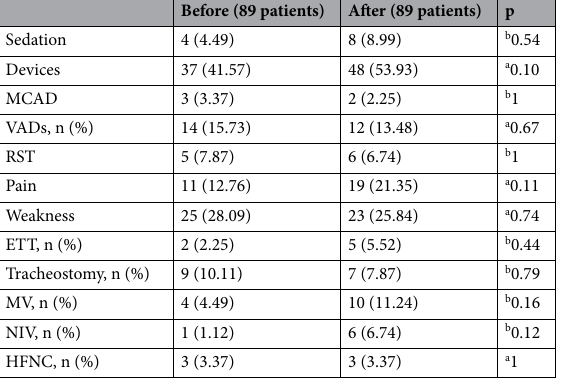
Table 3. Perceived barriers. MCAD mechanical circulatory assist device, VADs vasoactive drugs, RST renal supplementation therapy, ETT endotracheal intubation, MV mechanical ventilation, NIV non-invasive ventilation, HFNC high flow nasal cannula. a Pearson chi-square, b Fisher.